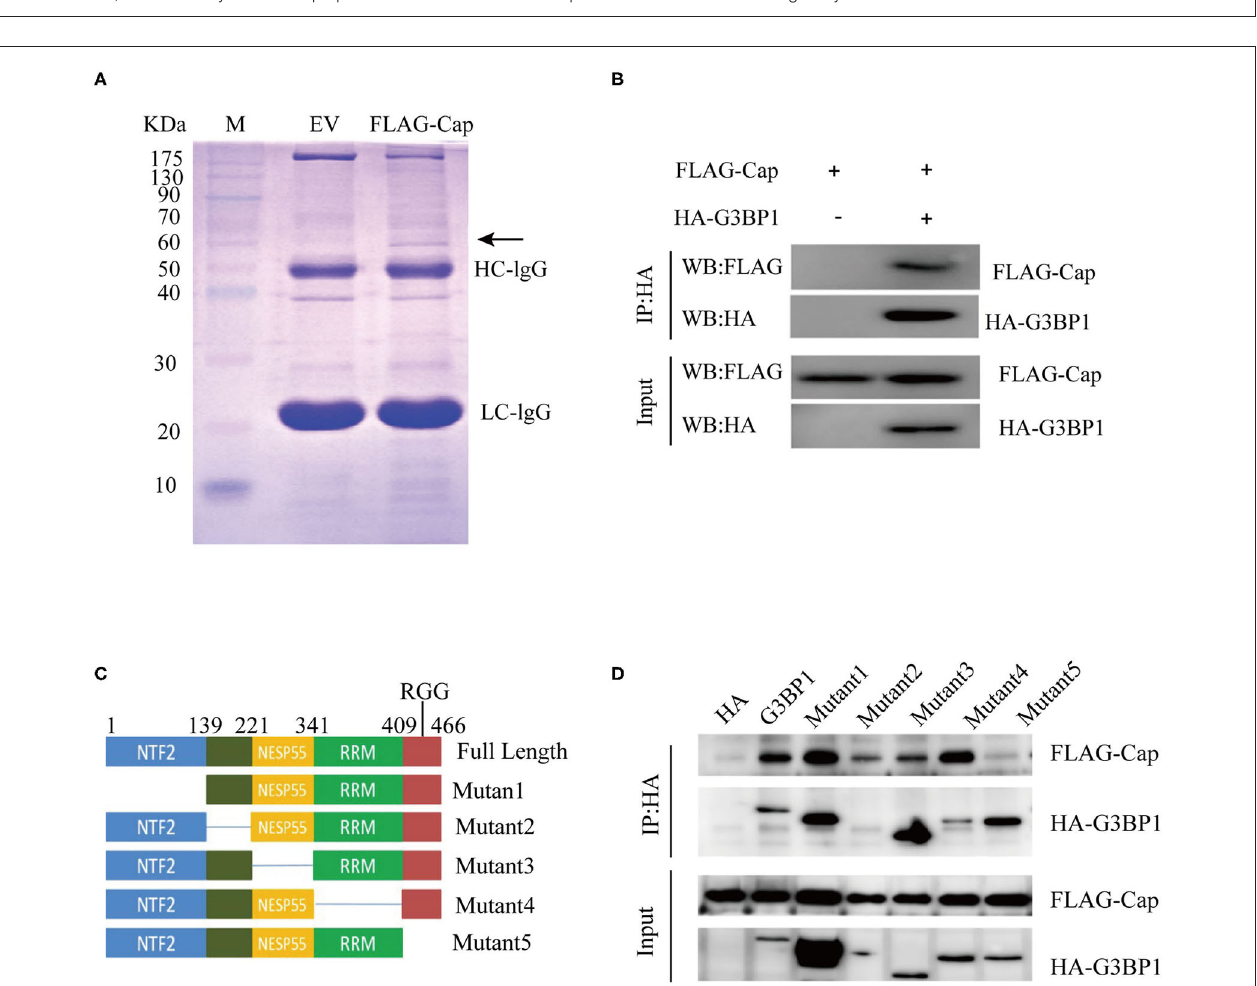
FIGURE 3 | Identifying Cap-interacting proteins. (A) SDS-PAGE analysis of Cap pull-down samples. PK15 cells were transfected with FLAG-Cap or FLAG vector. The cells were lysed for immunoprecipitation (IP) with anti-FLAG antibody. The precipitates were analyzed by SDS-PAGE. (B–D) Interaction between Cap and G3BP1. HEK 293T cells were co-transfected with FLAG-Cap and HA-G3BP1 (B) or various HA-G3BP1 mutants (D) . The cells were lysed at 24h post-transfection for IP using an anti-HA antibody, and the IP products were analyzed by western blotting. (C) Mapping the interacting regions between G3BP1 and Cap.